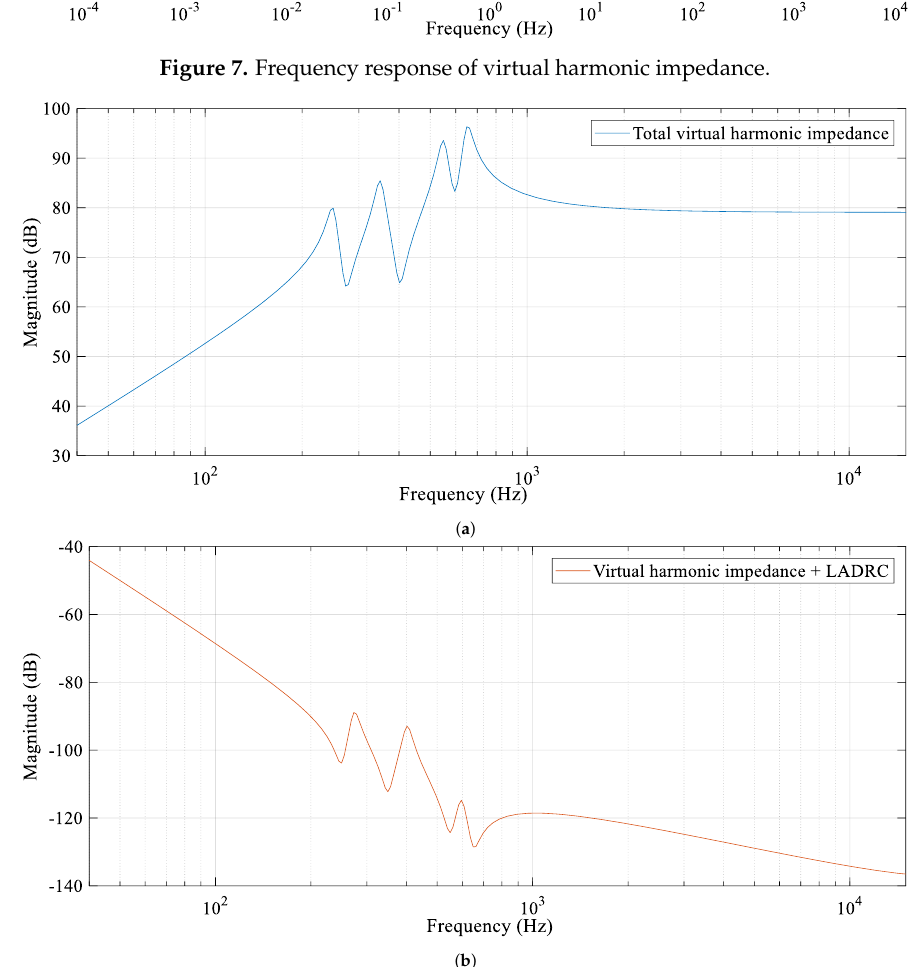
Figure 8. ( a ) Frequency response of total virtual harmonic impedance. ( b ) Frequency response of proposed